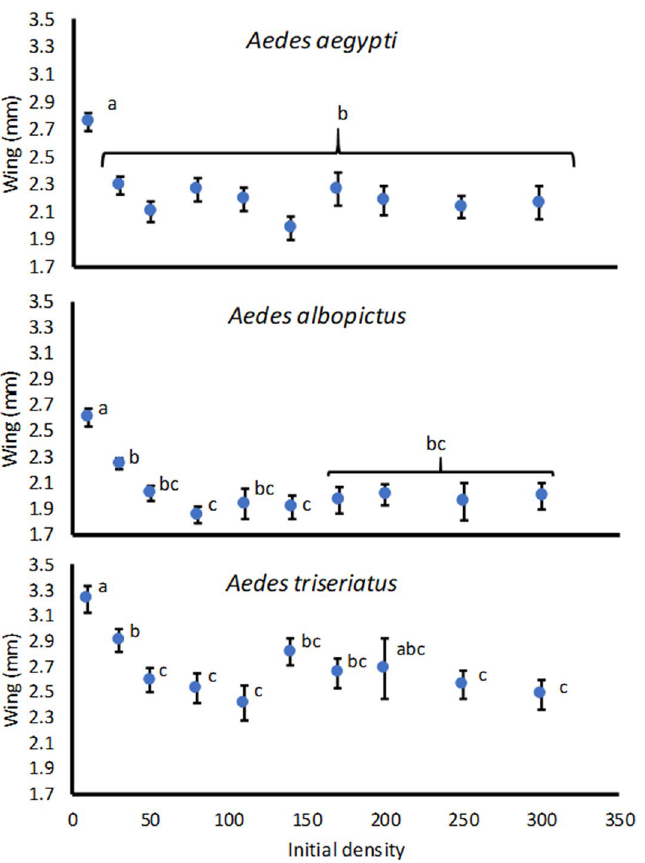
Figure 3. Least squares mean ± SE of cohort mean female wing length for Aedes aegypti, Aedes albopictus, and Aedes aegypti, averaged over replicate runs for each species. Means for a species associated with the same letters are not significantly different by Tukey’s multiple